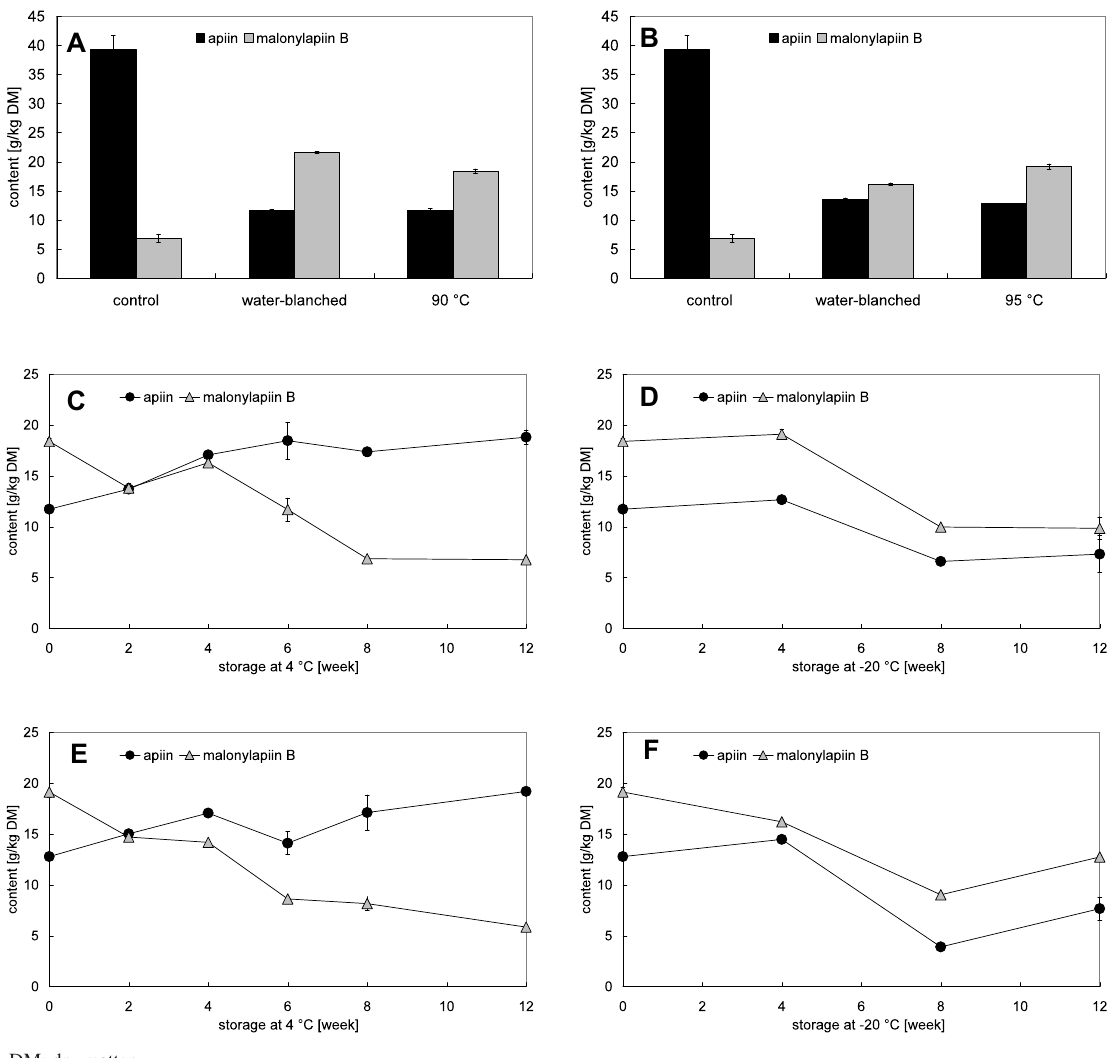
Fig. 2: Apiin and malonylapiin B contents during processing (A, B) and 12 weeks of storage (C-F) at 4 and -20 °C of parsley pastes: (A) processing at 90 °C, (B) processing at 95 °C, (C) storage at 4 °C of the pastes processed at 90 °C, (D) storage at -20 °C of the pastes processed at 90 °C, (E) storage at 4 °C of the pastes processed at 95 °C, (F) storage at -20 °C of the pastes processed at 95 °C. Columns and bars represent mean ± standard deviation (n = 2).